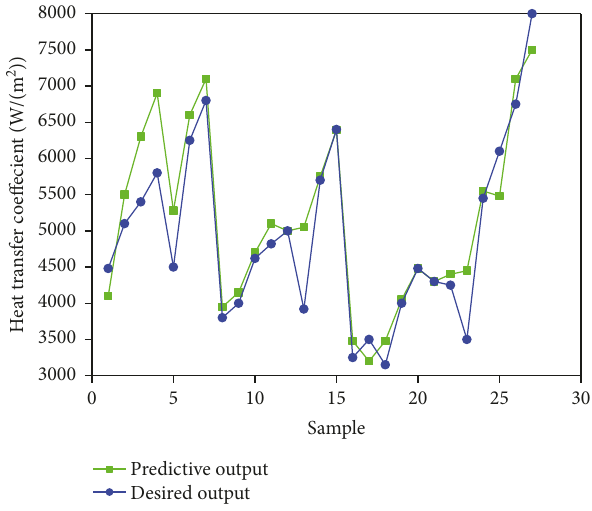
Figure 4: The GRNN network forecast